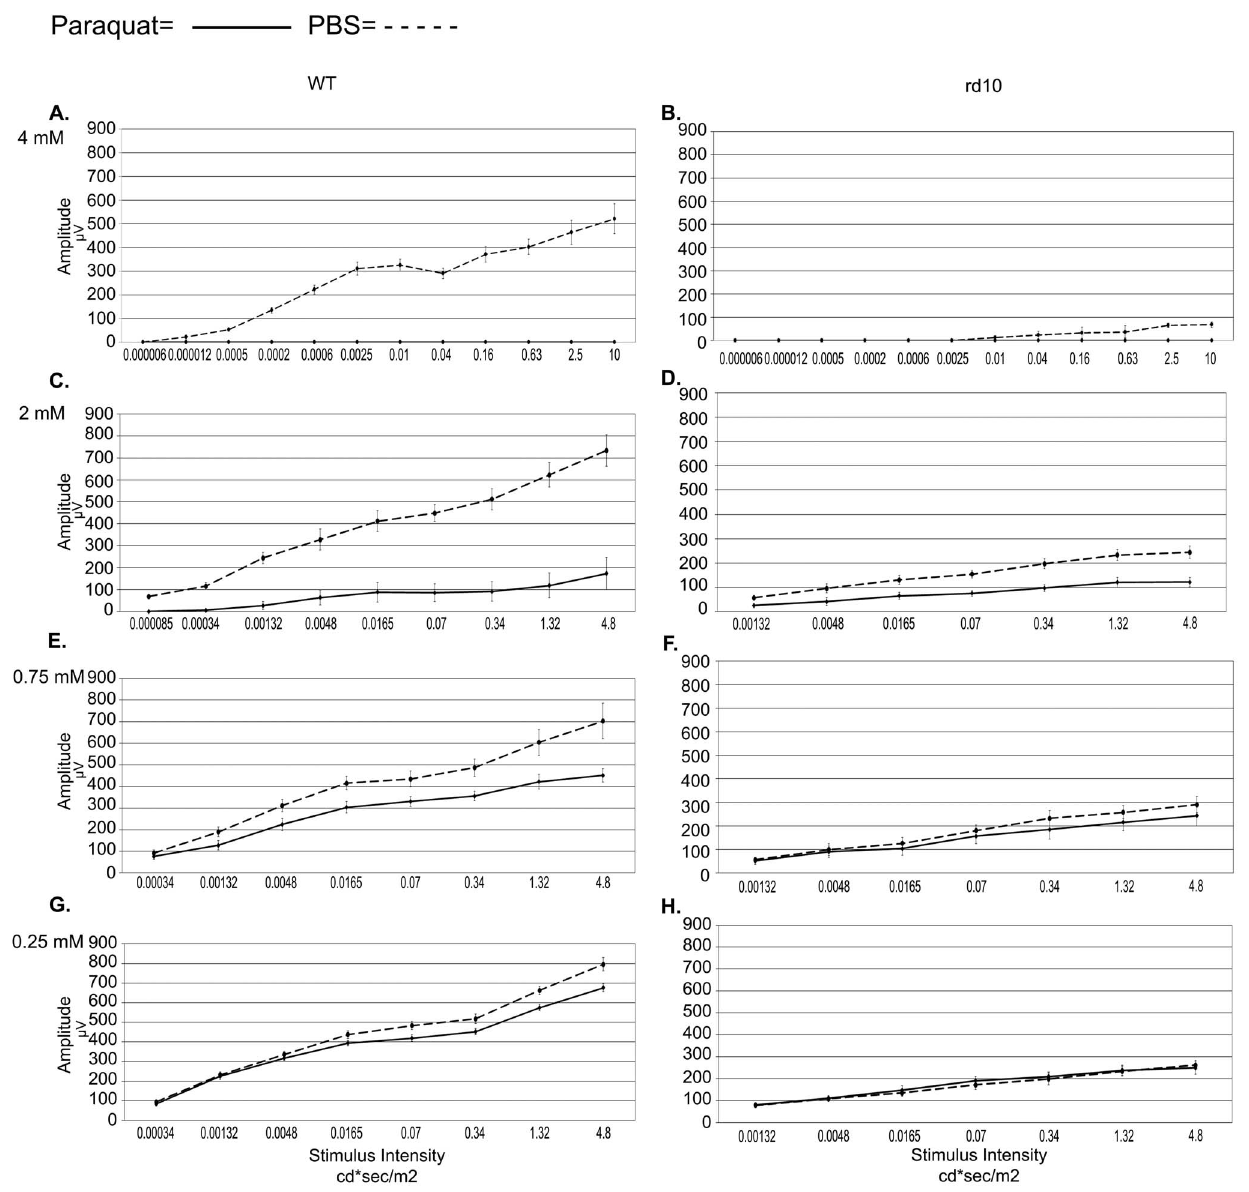
Figure 1. Scotopic b-wave ERG responses following intravitreal injection of PQ. ERGs were recorded three days following injection of 4 mM (A,B), 2 mM (C,D), 0.75 mM (E,F), or 0.25 mM (G,H) of PQ in one eye and PBS in the fellow eye of wild type (WT) and rd10 mice (n=10–22 in each group). Y-axis shows amplitude in microvolt while the x-axis shows the stimulus intensity.